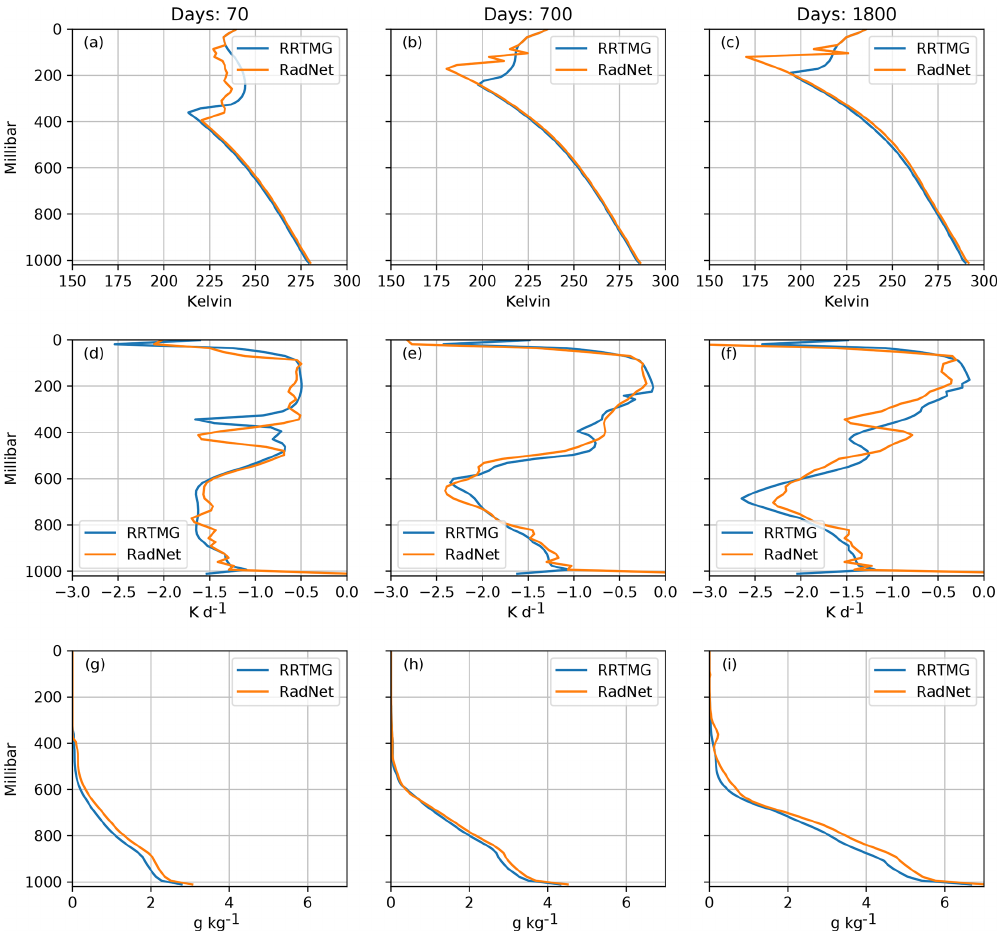
Figure 6. Comparison of the vertical profiles of (a–c) temperature, (d–f) longwave heating rates, and (g–i) specific humidity for the RadNet and RRTMG simulations at three different